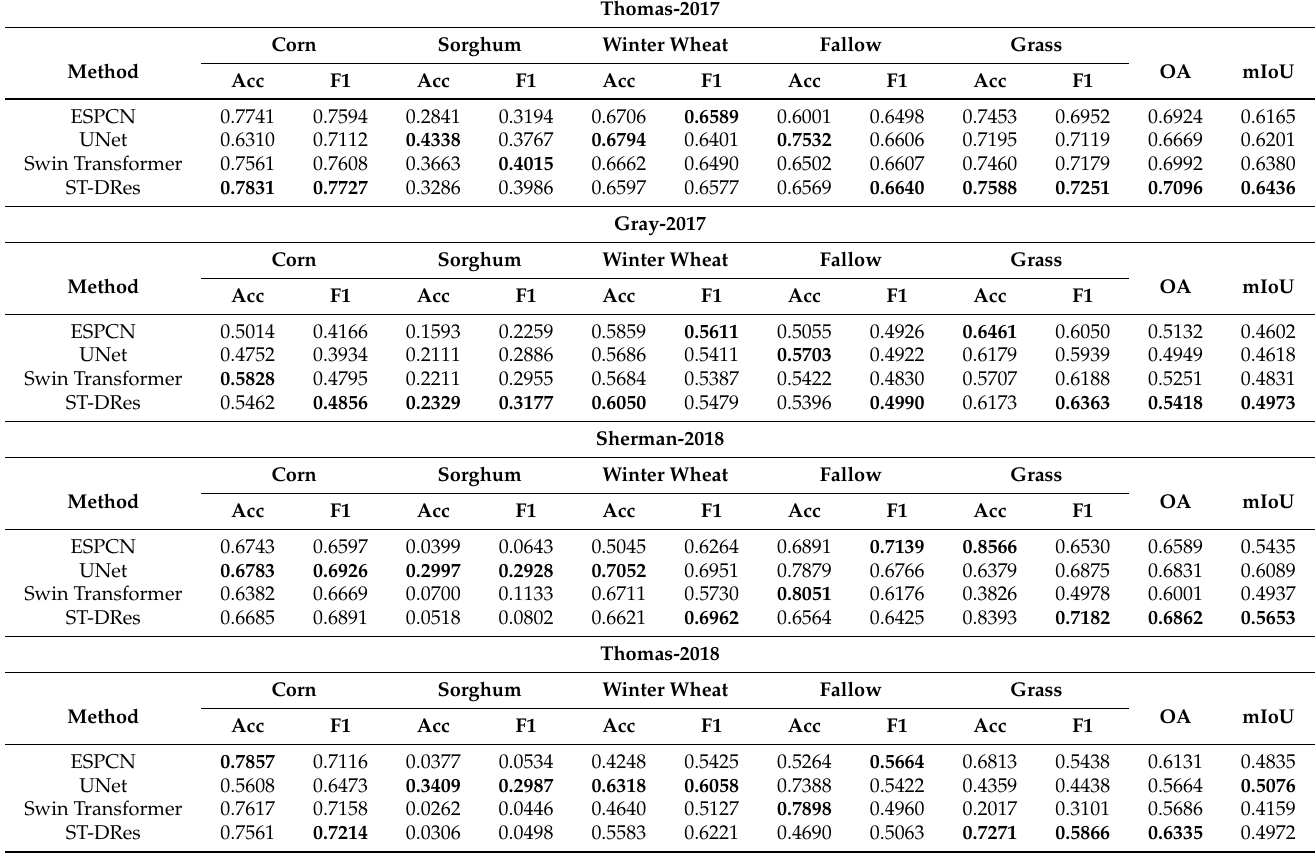
Table 6. The accuracy, F1 score of each class, mIoU, OA, and mean mIoU of the test sets of different methods (the highest accuracy in each column is in bold). The table is divided into five